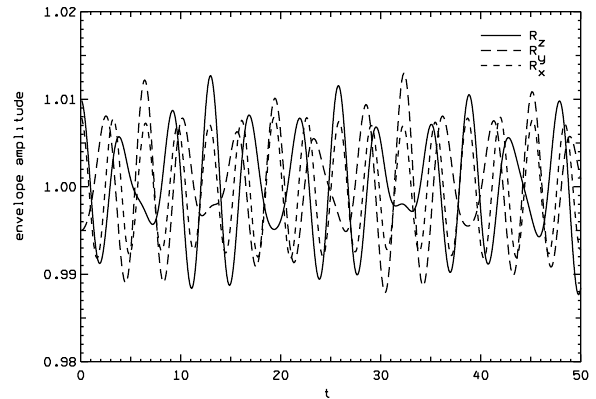
FIG. 1. The t -dependent envelopes for R x , R y , and R z with initial mismatch d R x (cid:1) 0.01 , d R y (cid:1) 2 0.05 , and d R z (cid:1) 0.008 .